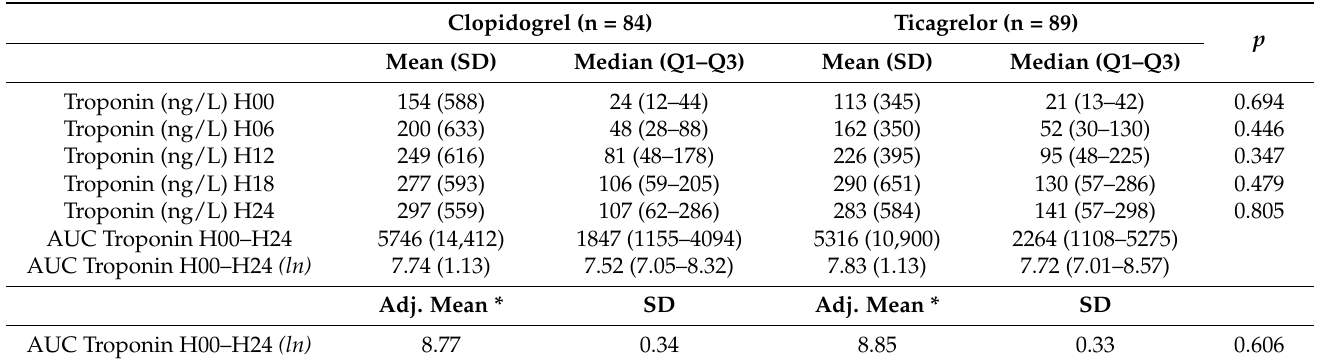
Table 3. Periprocedural troponin elevation.